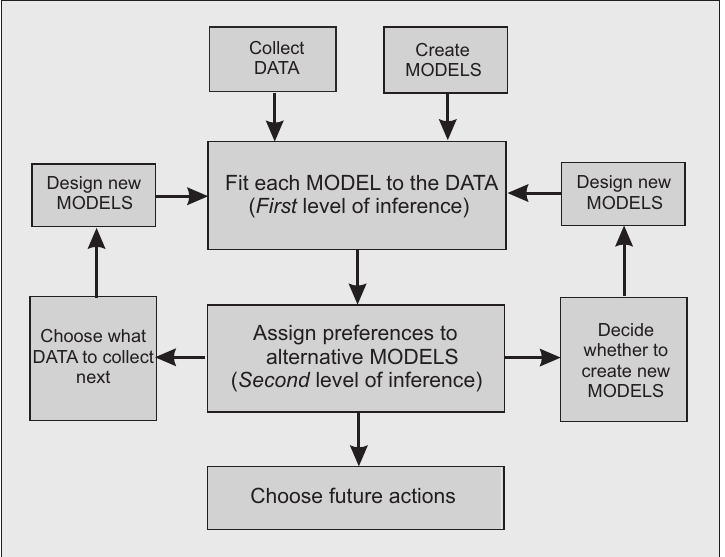
Figure 3. Statistical inference levels in data